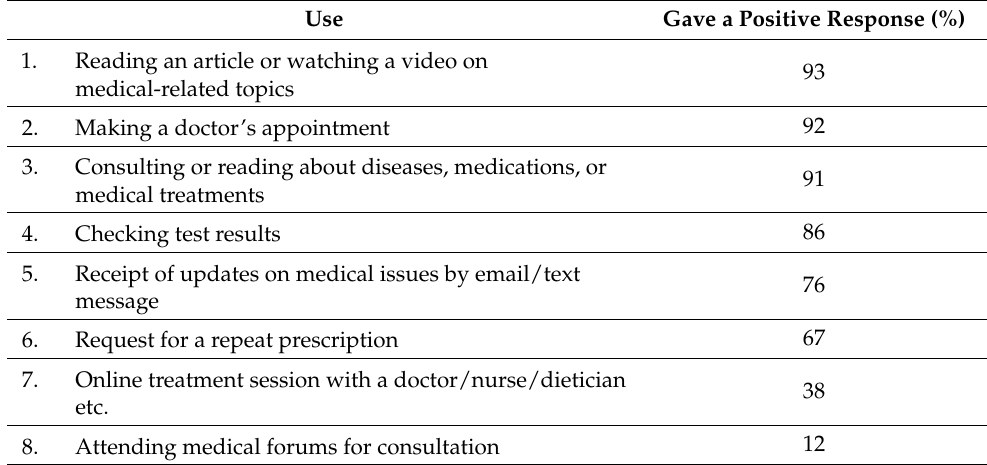
Table 2. Internet use for healthcare